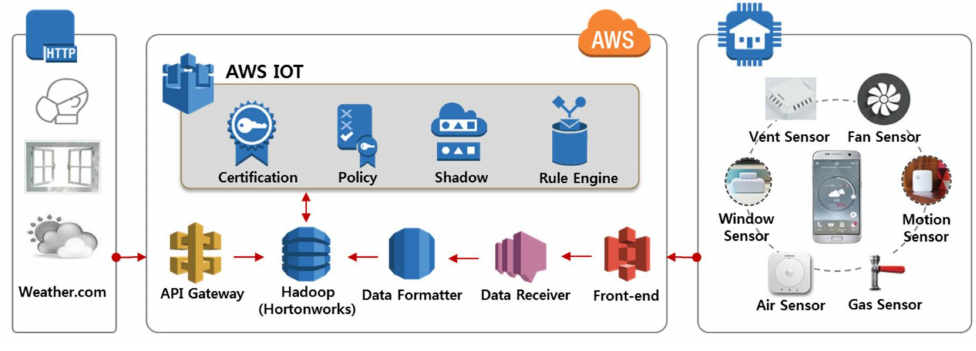
Figure 2. AWS-based home IoT